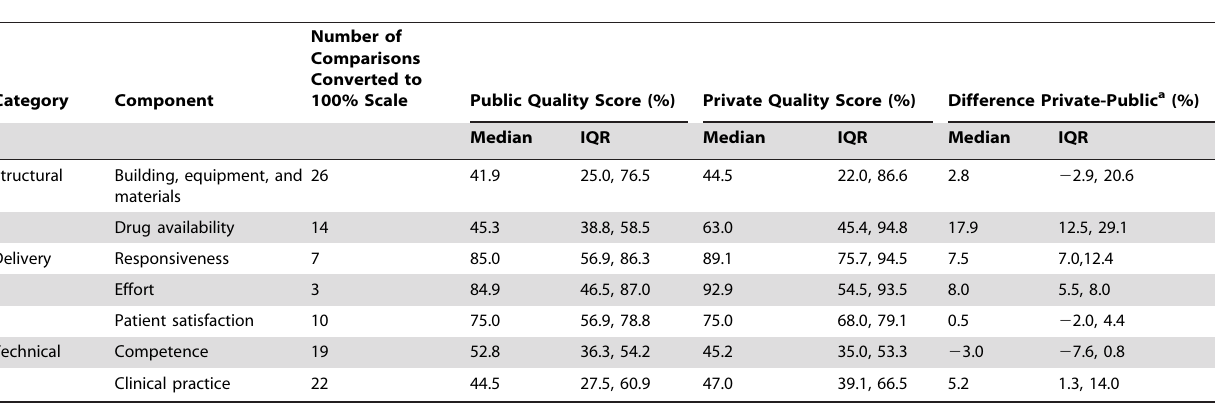
Table 3. Overall level of quality and comparative quality difference of public and formal private